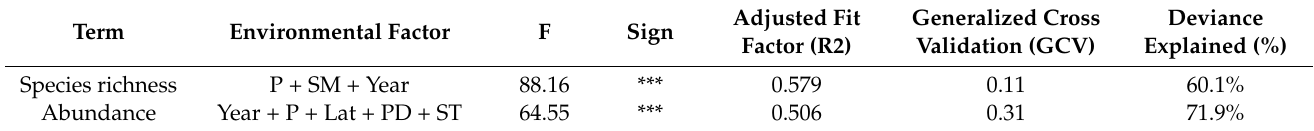
Table A3. Result of the Generalized Additive Mode (*** p < 0.001).